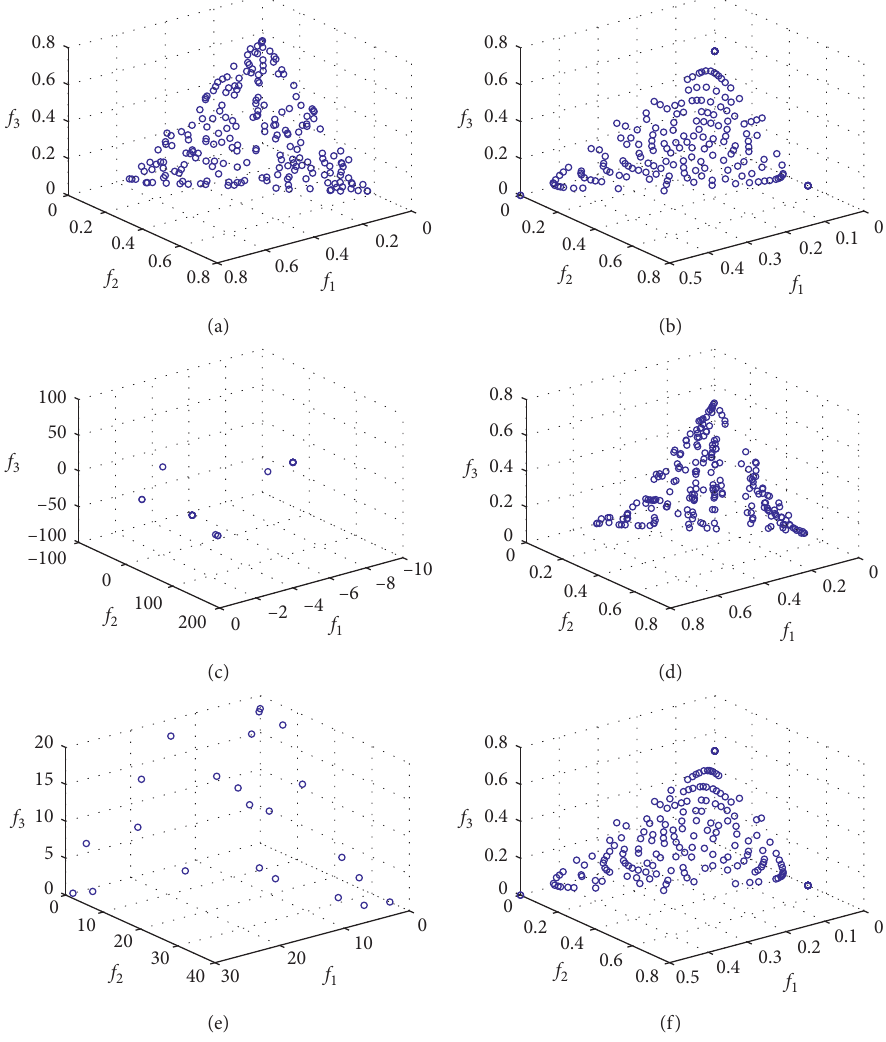
Figure 3: The approximate front of FMOESA, MOEA/D, dMOPSO, NSGAII, MOEA/D-STM, and MOEA/D-ACD on DTLZ1. (a) FMOESA, (b) MOEA/D, (c) dMOPSO, (d) NSGAII, (e) MOEA/D-STM, and (f) MOEA/D-ACD.